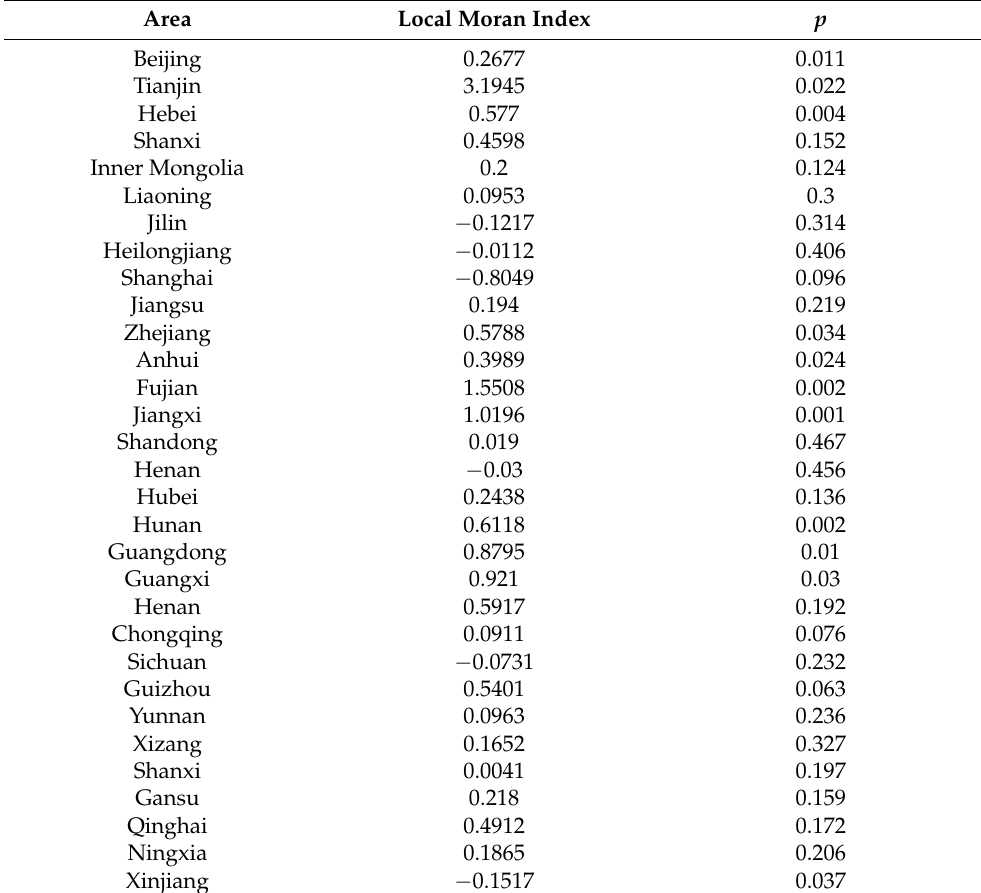
Table 5. Local Moran index in